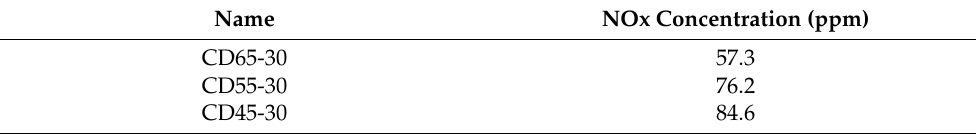
Table 5. Average NOx concentration at the furnace exit for CD65-30, CD55-30, and CD45-30.